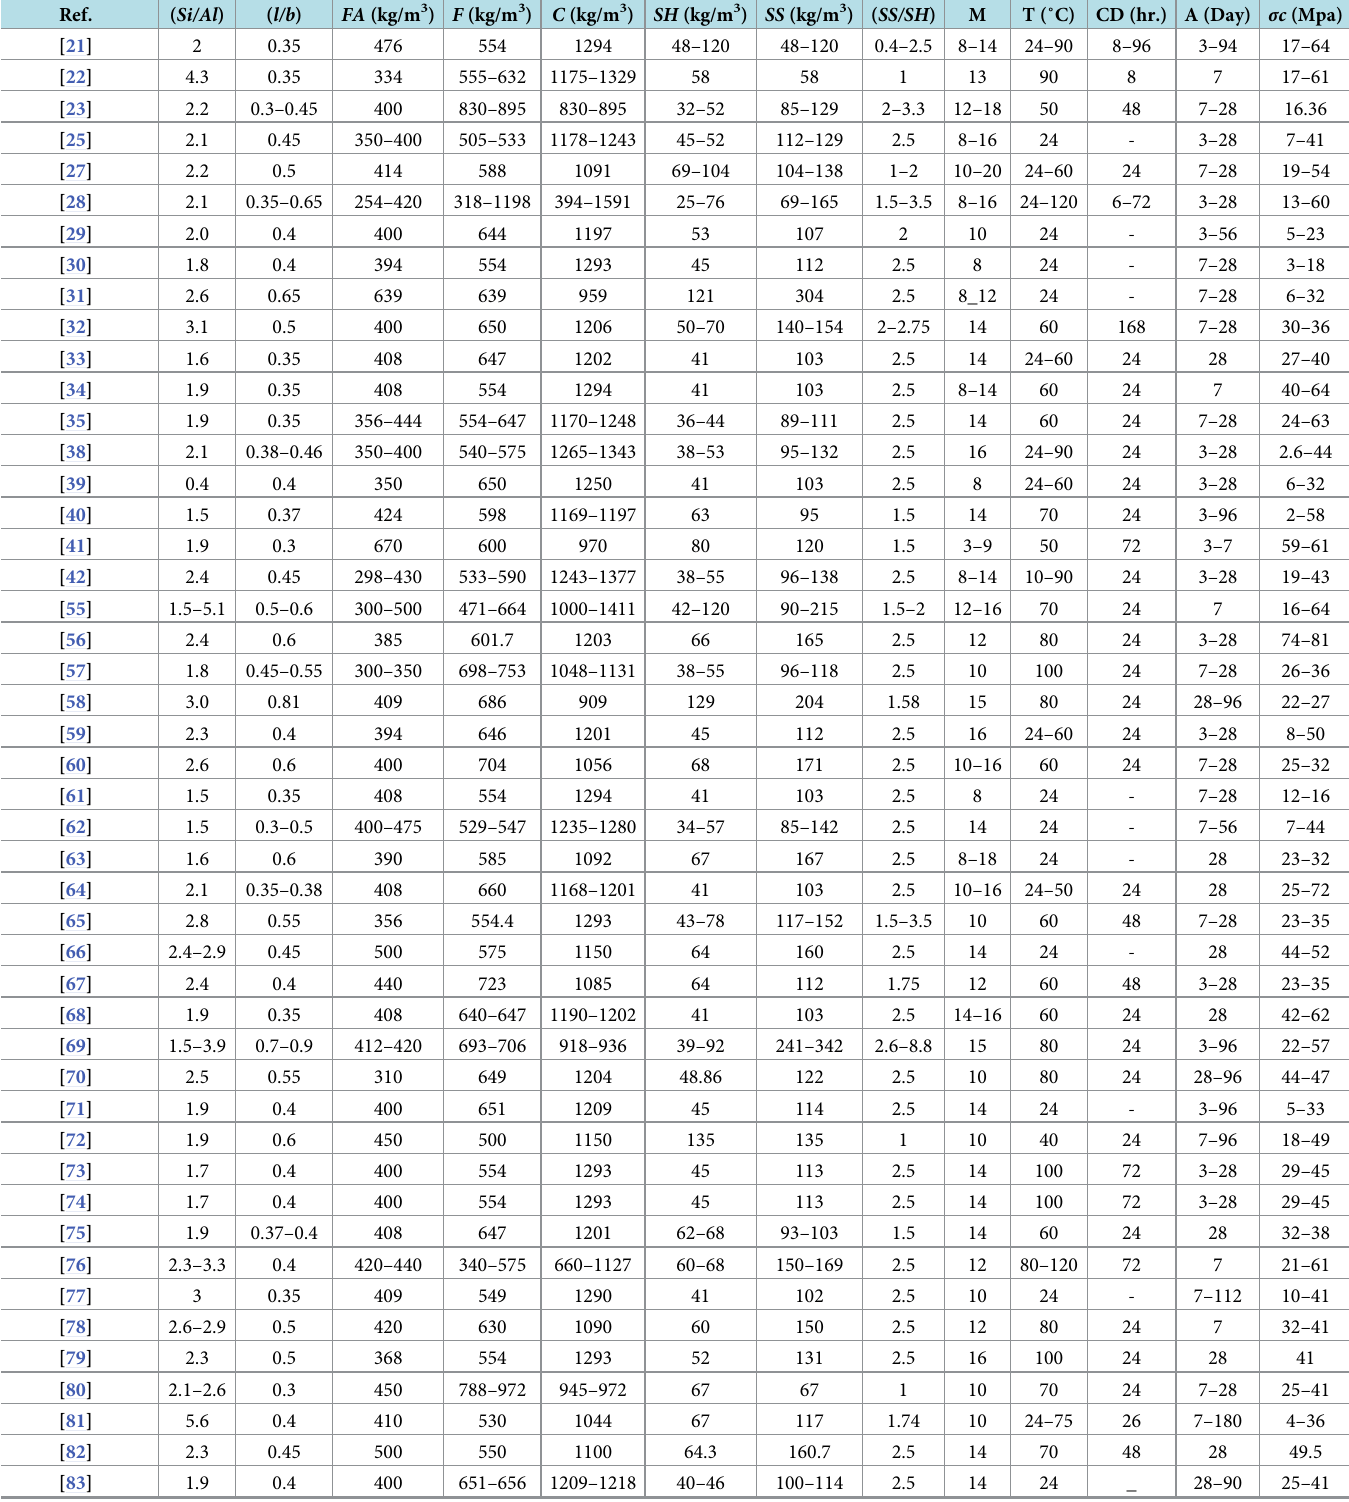
Table 1. Summary of different fly ash-based geopolymer concrete mixes.